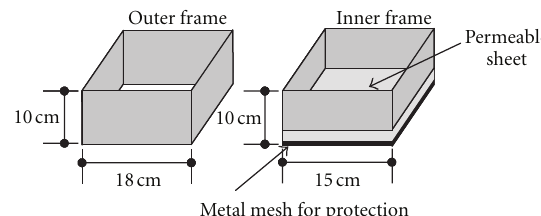
Figure 7: Box for recording the weight of grass and bare